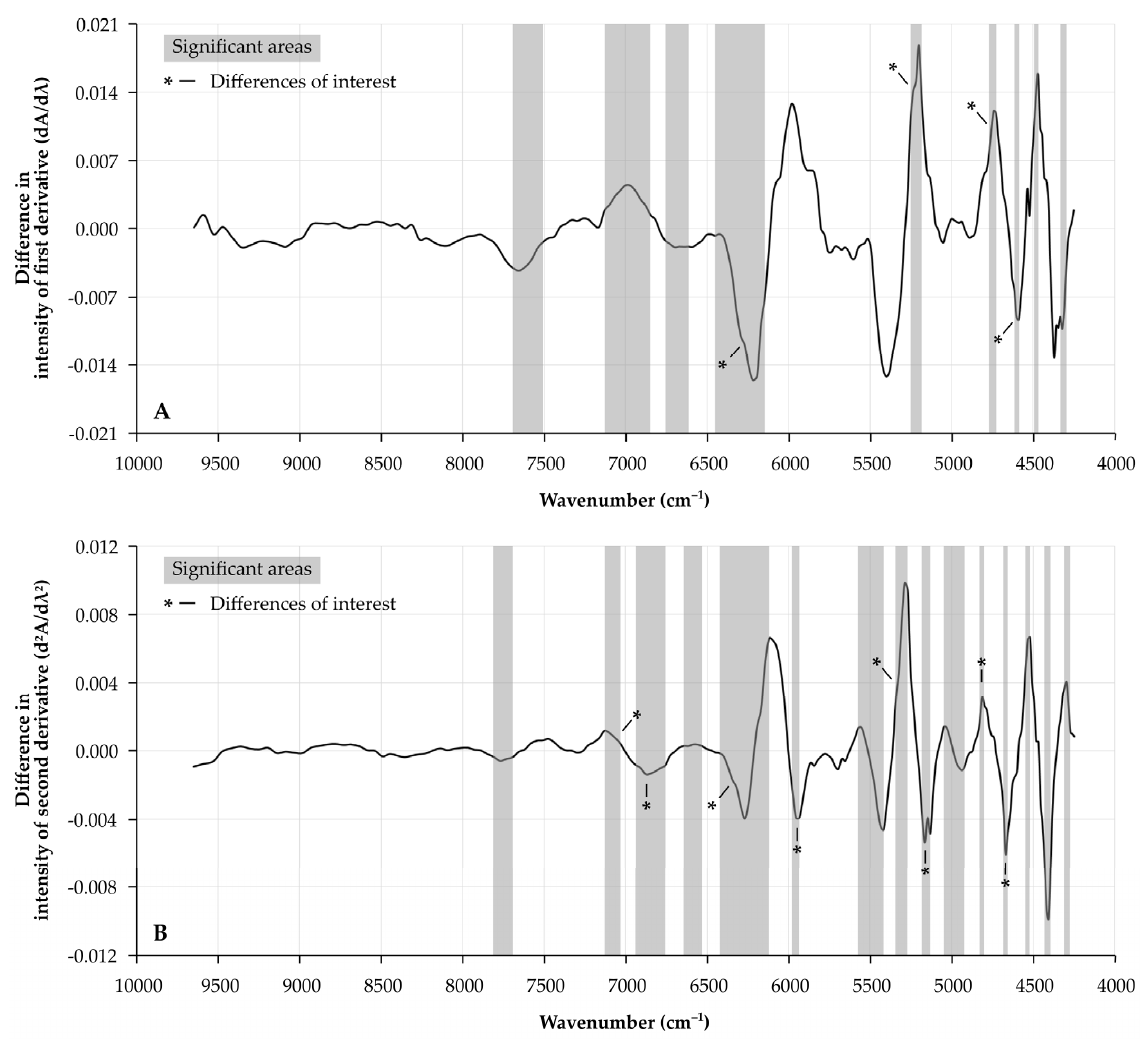
Figure 2. Median differences in NIR spectra of prostatectomy specimens from patients with or without BCR. X-axis depicts wavenumber (cm − 1 ). Spectral differences in intensity are illustrated for ( A ) the 1st derivative (dA/d λ ) and ( B ) the 2nd derivative (d 2 A/d λ 2 ). Significantly different areas have been highlighted in grey. Changes reaching a significance of p < 0.001 have been indicated with an asterisk, and the spectral variation of these wavenumbers has been further illustrated in Supplementary Figures S2 and S3. A : absorbance; BCR: biochemical recurrence; λ : wavelength; and NIR: near-infrared.